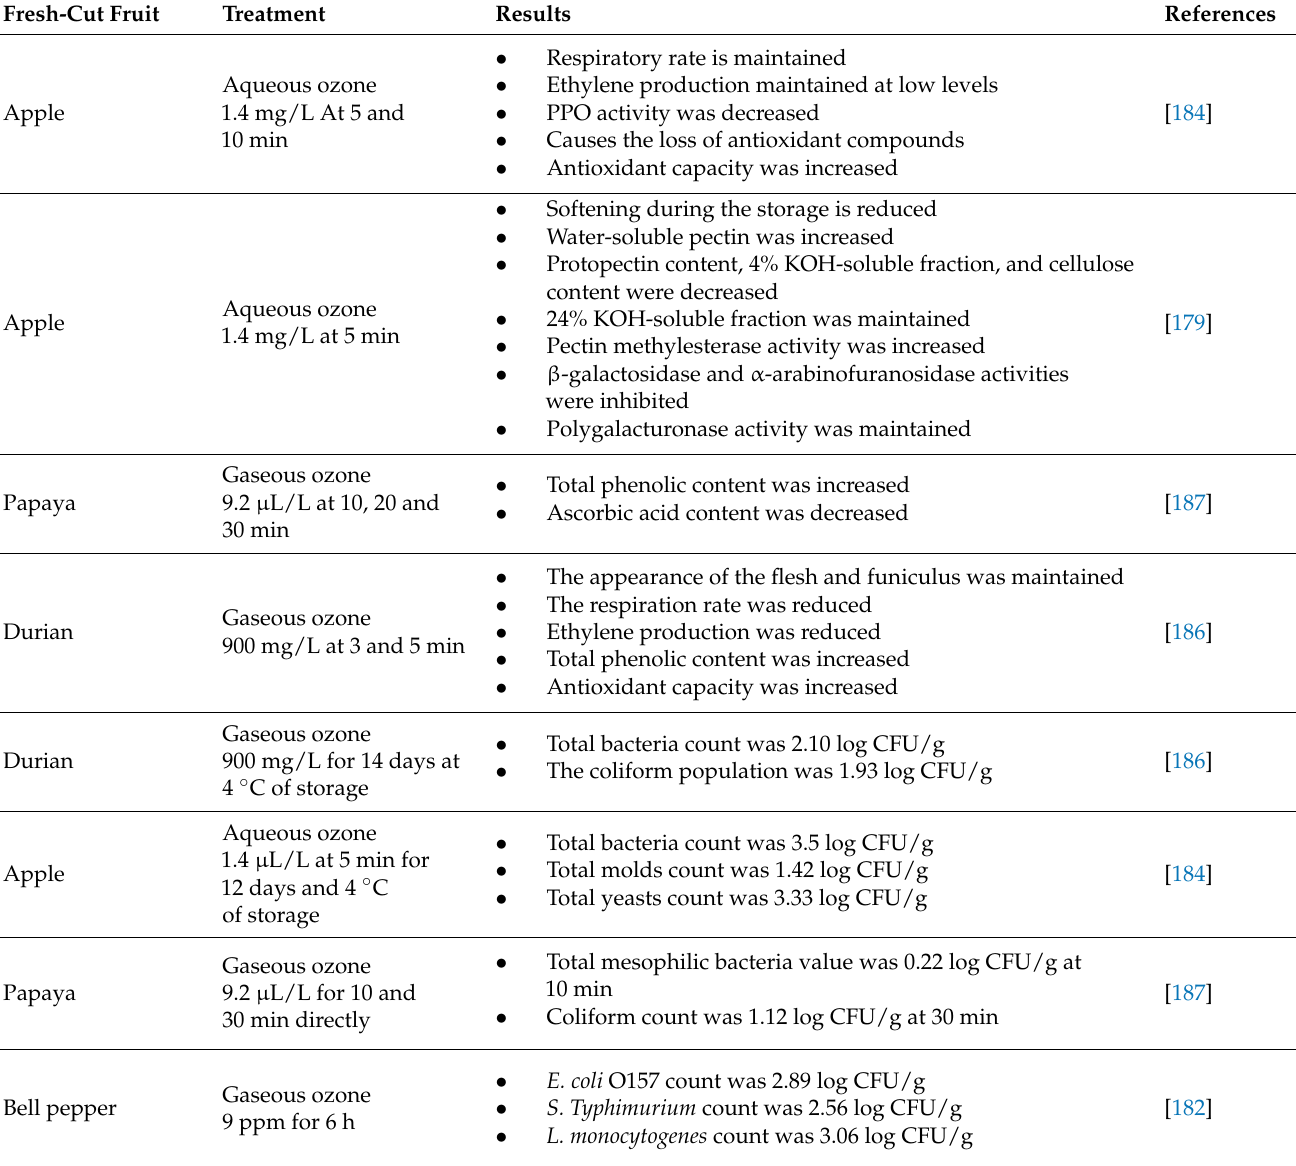
Table 4. Quality parameters and microbiological control of fresh-cut fruits treated with aqueous or gaseous